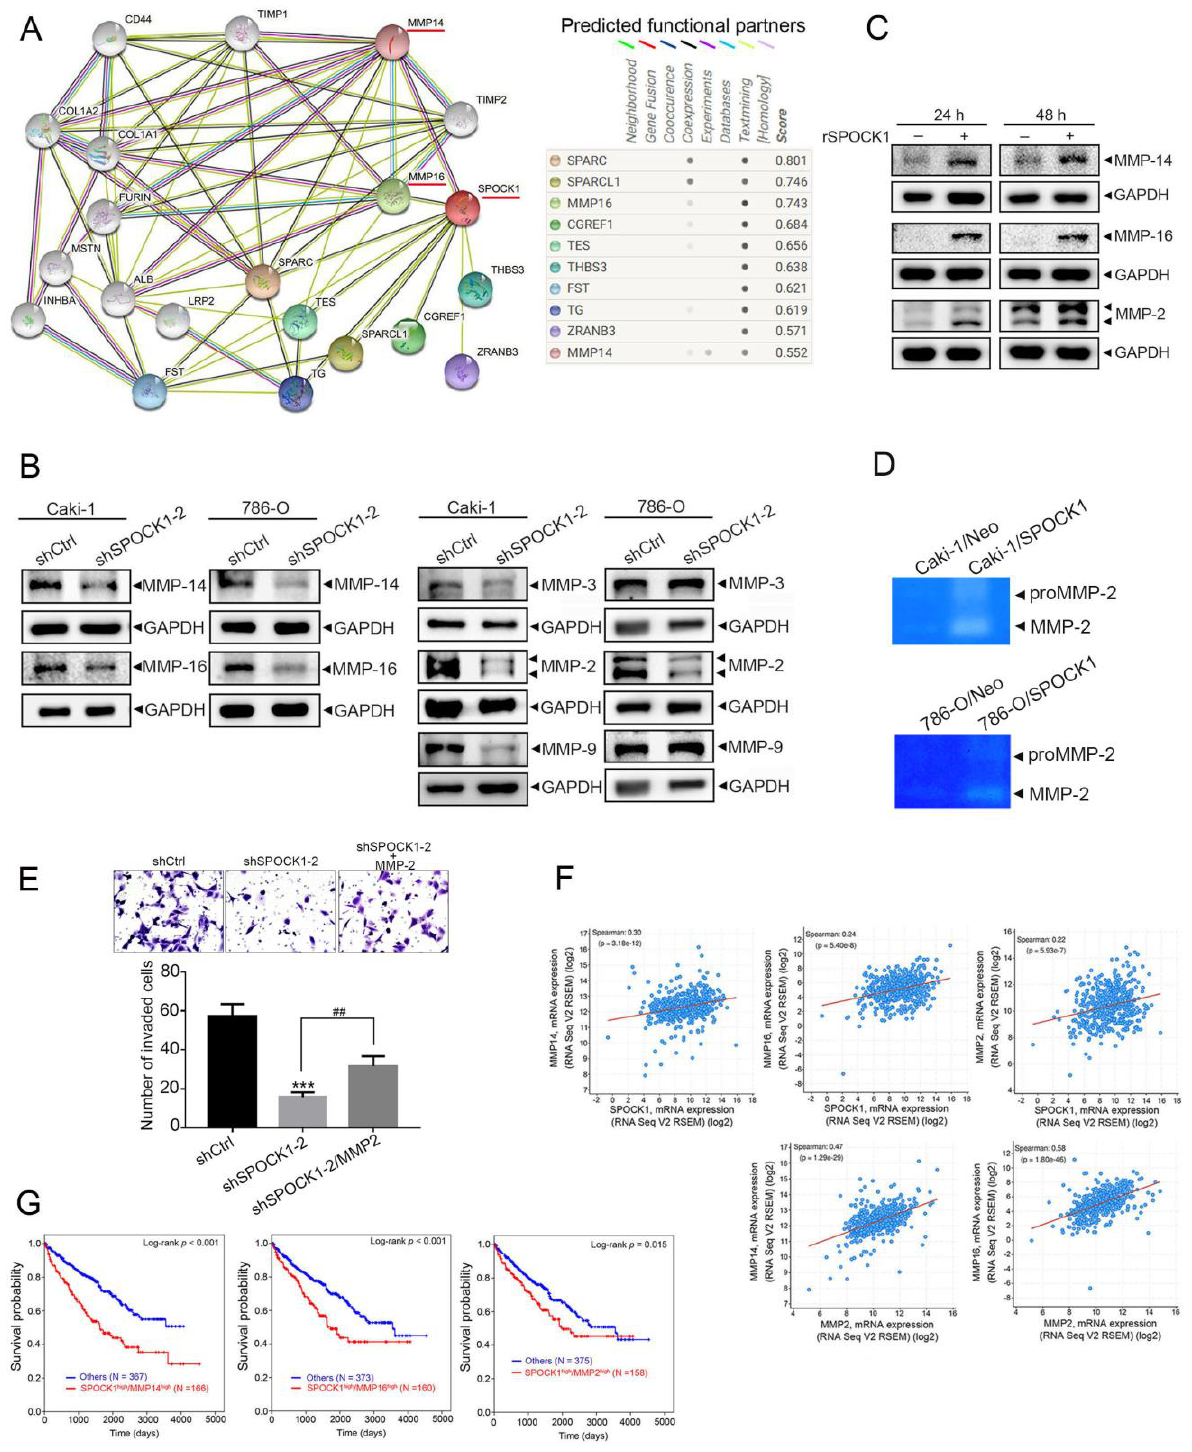
Figure 4 . SPOCK1 regulates motility via inducing matrix metalloproteinase Figure 4. SPOCK1 regulates motility via inducing matrix metalloproteinase (MMP)-14/MMP-16-mediated (MMP) − 14/MMP − 16 − mediated MMP − 2 activation in clear cell renal cell carcinoma (ccRCC) cells. MMP-2 activation in clear cell renal cell carcinoma (ccRCC) cells. ( A ) SPOCK1 protein–protein interaction ( A ) SPOCK1 protein – protein interaction network of 10 differentially expressed genes from the network of 10 differentially expressed genes from the STRING database. ( B ) Caki − 1 and 786 − O cells were infected with a lentivirus carrying either SPOCK1 shRNA or shCtrl and subjected to a Western blot analysis to determine expressions of MMP − 16, MMP − 14, MMP − 9, MMP − 3, and MMP − 2. ( C ) Treatment of Caki − 1 cells with or without the recombinant SPOCK1 protein (rSPOCK1, 1 ng/mL) for 24 and 48 h, and expressions of MMP − 16, MMP − 14, and MMP − 2 were detected by Western blotting. Quantitative results of indicated MMP